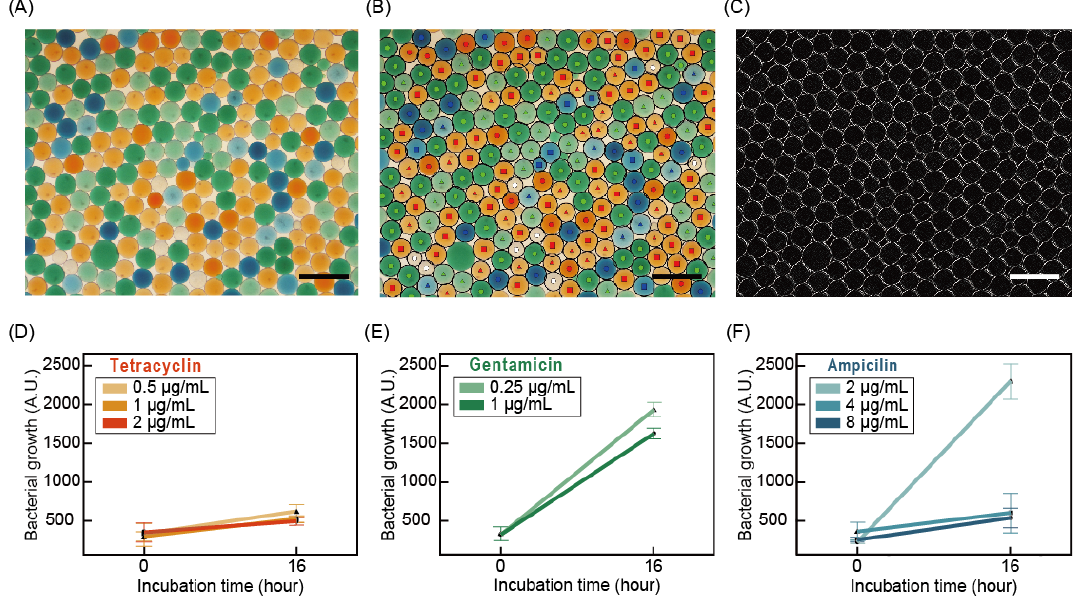
Figure 5. Multiplexed color-coded droplets for antibiotic susceptibility testing. ( A ) Microscopy images of the color-coded multiplexed droplet with bacterial cells. ( B ) Decoding color codes of droplets. ○ : control, ▲ (low) ■ (medium) ● (high) concentration of tetracycline, ▲ (low) ■ (medium) concentration of gentamicin, ▲ (low) ■ (medium) ● (high) concentration of ampicillin. ( C ) The detected edges of the droplets. Differences in bacterial growth and interpretation of MIC results with a time of incubation of ( D ) tetracycline, ( E ) gentamicin, and ( F ) ampicillin (standard deviations are indicated). Scale bars represent 500 µm in subfigures ( A – C ).